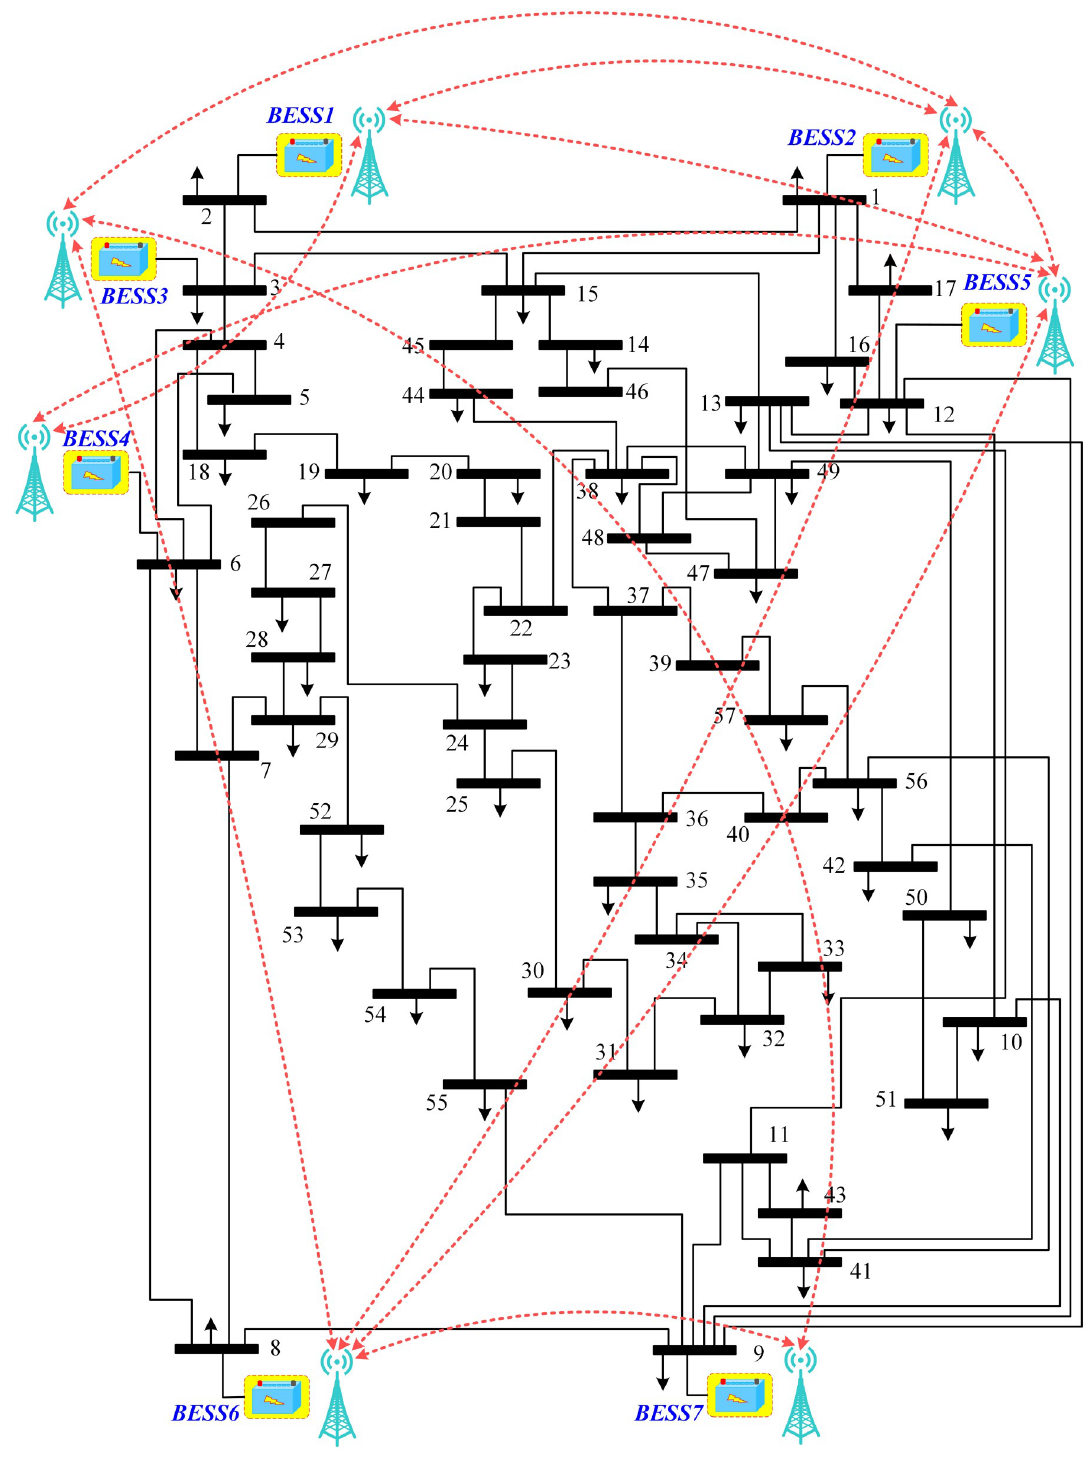
Fig 2. Modified IEEE 57-bus system.